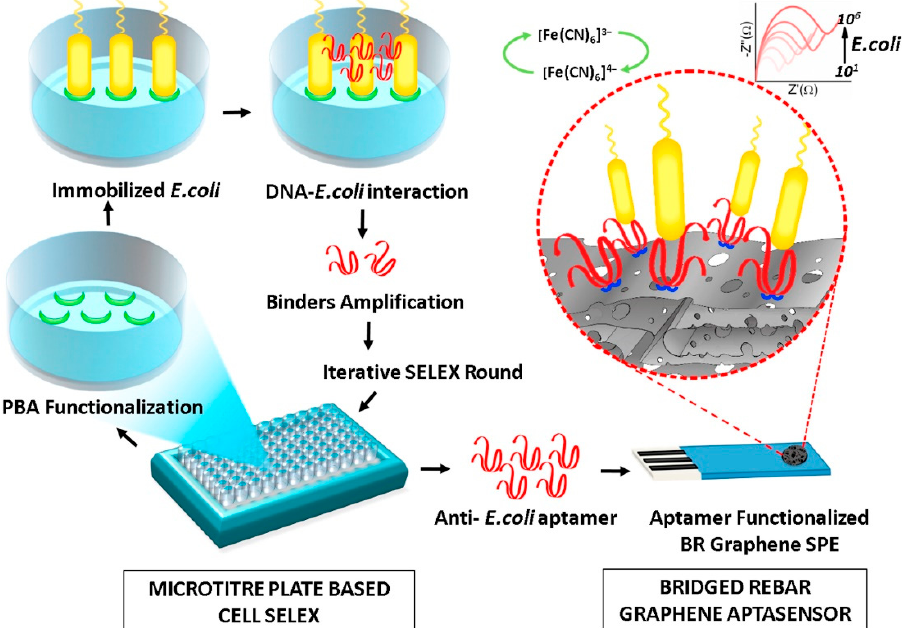
Figure 6. Schematic representation of the assembling and the sensing approach of the E. coli aptasensor. Reprinted with permission from [117] Copyright 2017 Elsevier.